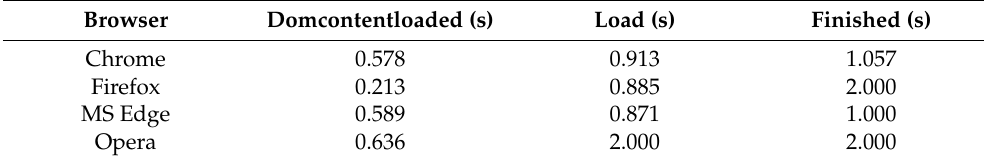
Table 4. Browser-specific loading time. Source: Map Collection of the Faculty of Science, Charles University.